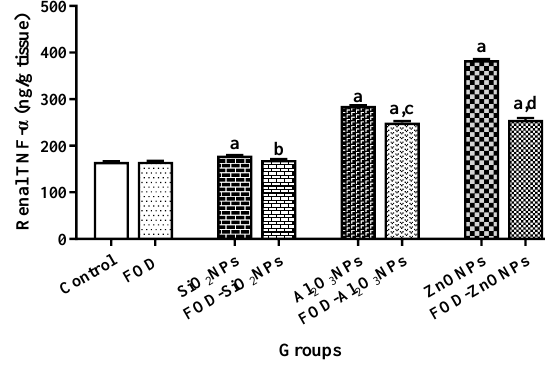
Fig. 1. The effects of fig with olive oil and date-palm fruit extracts (FOD) on the renal tumor necrosis factor-α (TNF-α) in rats treated with different nanoparticles (NPs) for 75 days. a p<0.05, versus control group; b p<0.05, versus SiO 2 NPs; c p<0.05, versus Al d p<0.05, versus ZnONPs. N.B: 2 O 3 NPs; The antioxidants (FOD) treatments were used for 2 weeks before and during the administration of the nanoparticles.